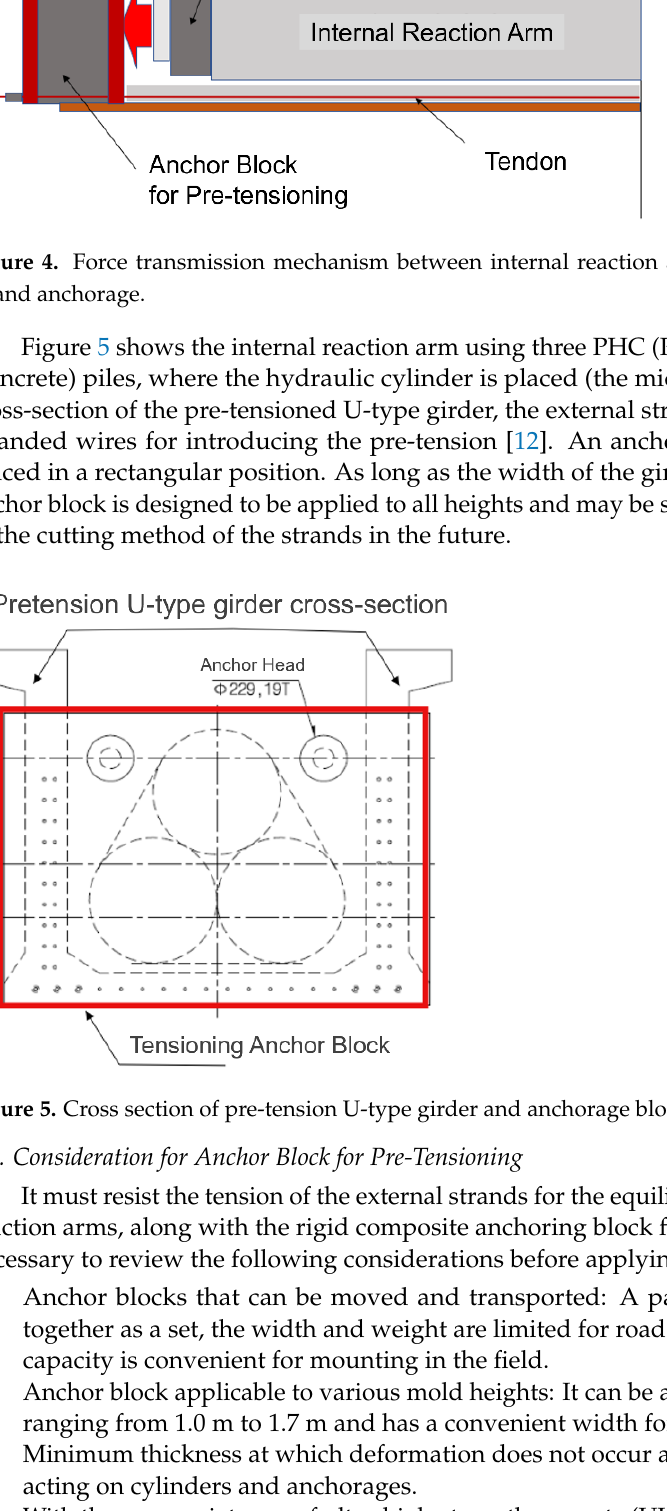
Figure 4. Force transmission mechanism between internal reaction arm-hydraulic cylinder and strand anchorage.